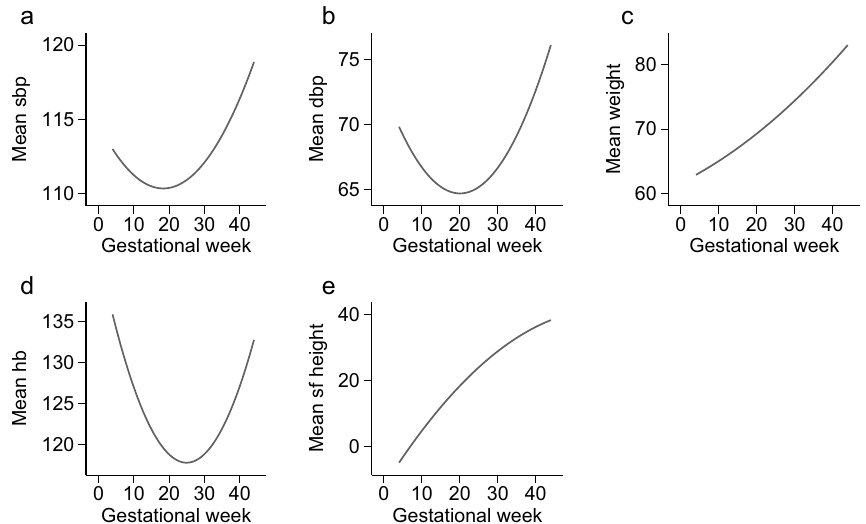
Figure 1. Among women not developing preeclampsia, trajectories of: ( a ) mean systolic blood pressure (sbp), ( b ) mean diastolic blood pressure (dbp), ( c ) mean maternal weight (weight), ( d ) mean symphysis-fundal measure (fundus), and ( e ) mean haemoglobin level (Hb) throughout